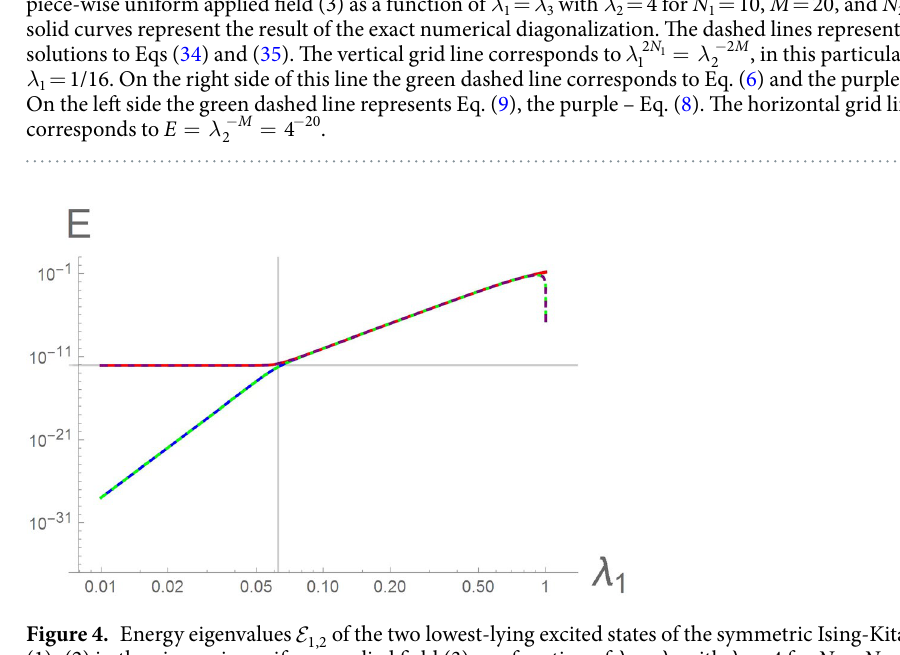
2 1 , in this particular case, 2